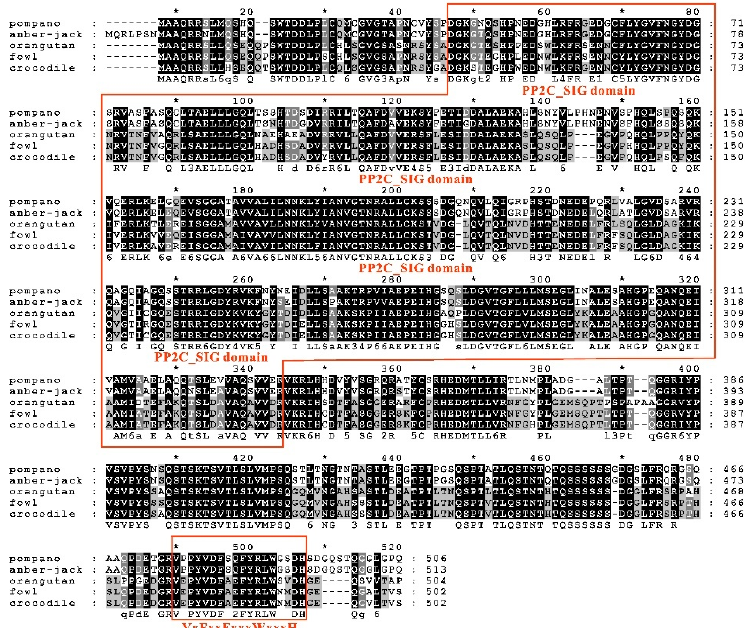
Figure 4. Multiple amino acid sequence alignment between trTAB1 and other vertebrates’ TAB1. The PP2C_SIG domains and ‘VxFxxFxxxWxxxH’ sequence of trTAB1 are boxed. Asterisk is